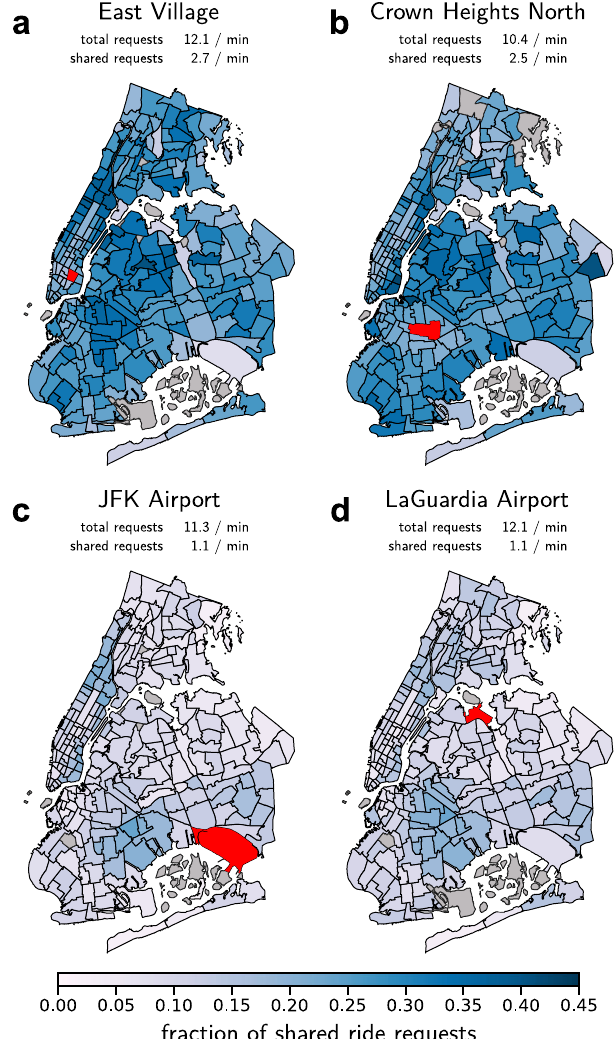
Fig. 1 Contrasting ride-sharing adoption despite high request rate in New York City. Fraction of shared ride requests from different origins (red) served by the four major for-hire vehicle transportation service providers in New York City by destination zone (January - December 2019) 33 . Gray areas were excluded from the analysis due to insuf fi cient data (see Methods). The fraction of shared ride requests differs signi fi cantly by origin and destination with a complex spatial pattern across destinations, even though the average overall request rate is similar for all four origin locations. a , b Some areas, such as East Village and Crown Heights North, show a high adoption of ride-sharing services. c , d Despite a similarly high request rate, other locations, such as JFK and LaGuardia airports, show a signi fi cantly lower adoption of ride-sharing